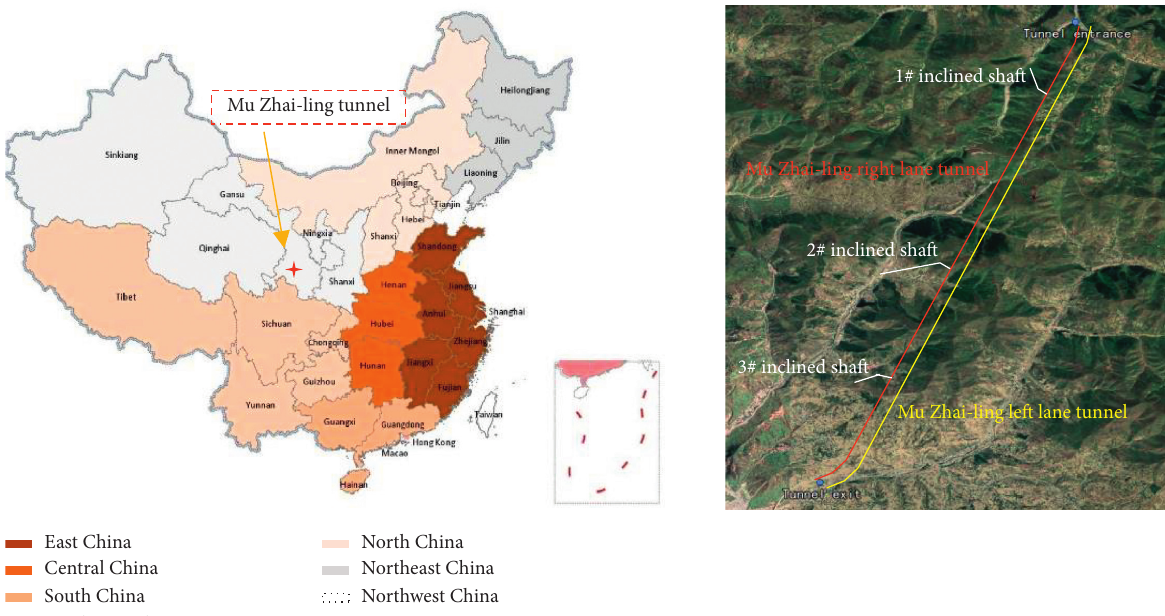
Figure 2: (a) Location of the Mu Zhai-ling tunnel, Gansu, China. (b) Plane view of the tunnel.